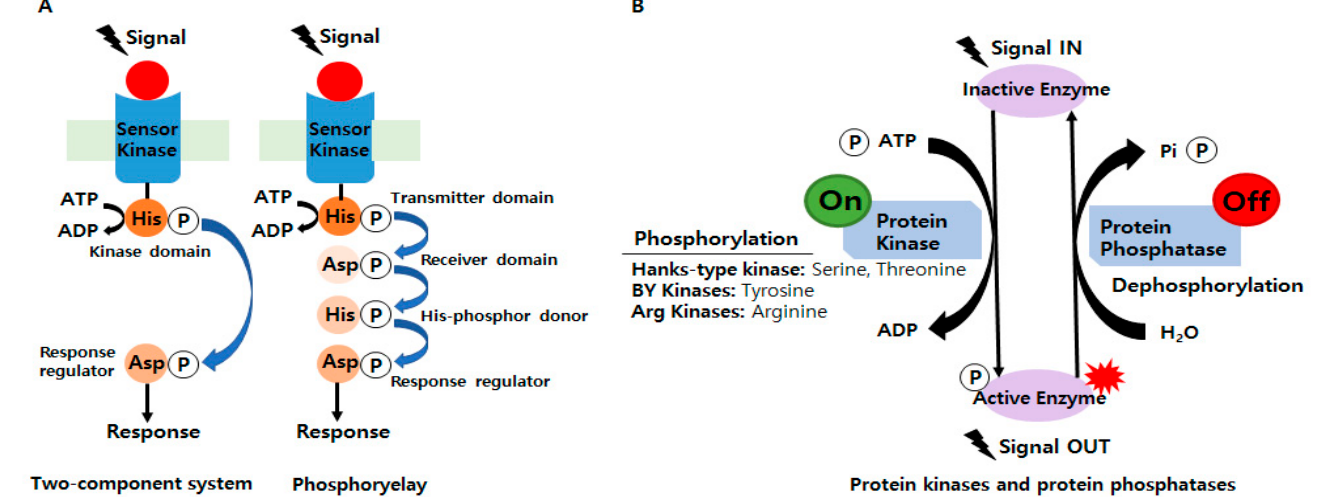
Figure 1. ( A ) Schematics of the prototypical two-component systems (TCSs) and phosphorelay sys- tems in bacteria. ( B ) The overall mechanism of protein phosphorylation regulated by protein kinases and protein phosphatase.